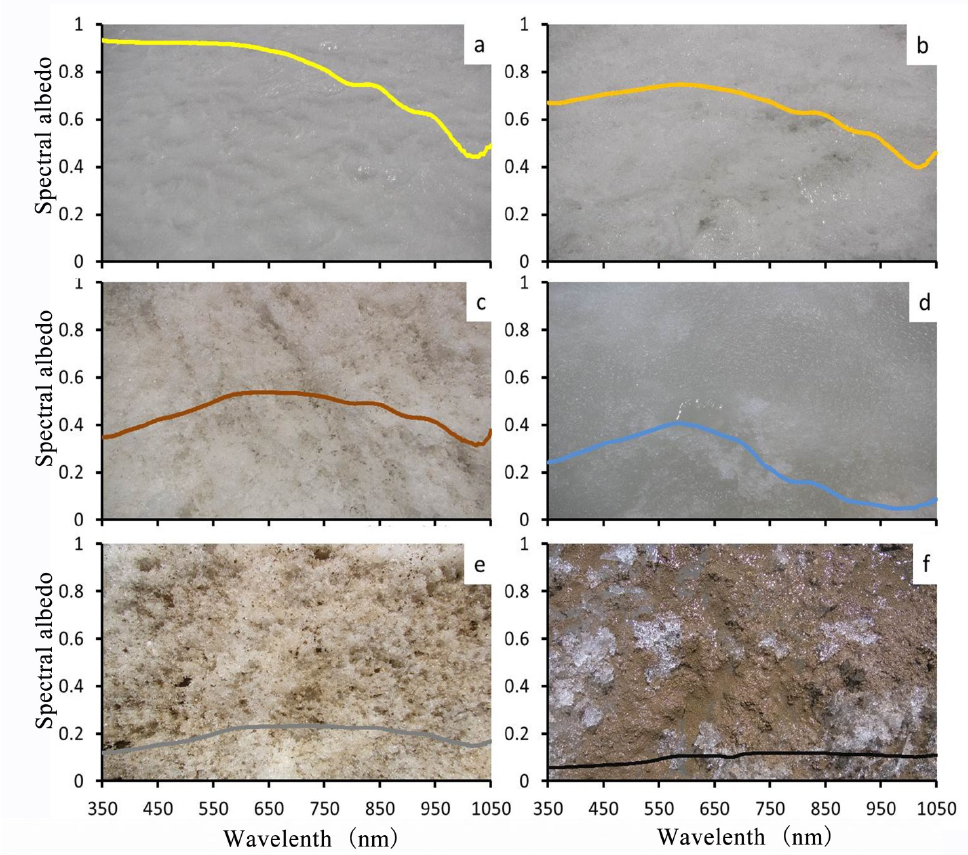
Figure 12. Spectral albedo measurements for different types of snow surfaces and different melting stages. ( a – f ) represent the evolution from fresh snow to cryoconite that accumulated on the QT No. 1 Glacier’s surface, and ( d ) shows an example of snow with a high water content. Each spectrum was determined from the same number of photographs. Snow has a certain degree of transparency, although it becomes opaque when it reaches a particular thickness; thus, the surface beneath thin snow layers also influences albedo. Most glaciers have relatively thin surface snow. During the ablation periods of the QT No. 1 Glacier, the surface snow thicknesses were consistently less than 100 cm, with mean values of ~30 cm. During field work, we compared the albedo before and after the removal of surface snow. For example, on 16 June 2015, after a snowfall event on the QT No. 1 Glacier, we removed 9.5 cm of surface snow observation point 3 to expose the ice surface. We subsequently used a brush to remove residual snow particles and measure the albedo of the new surface. The blue line in Figure 13 shows the reflection spectrum before removing the surface snow, and the red line shows the post-removal spectrum. A comparison of both curves shows a significant reduction in reflectance after removing the surface snow and the albedo decreased from 0.9 to 0.5 (Figure 13). Thus, the presence or absence of surface snow has a significant effect on a glacier’s albedo.